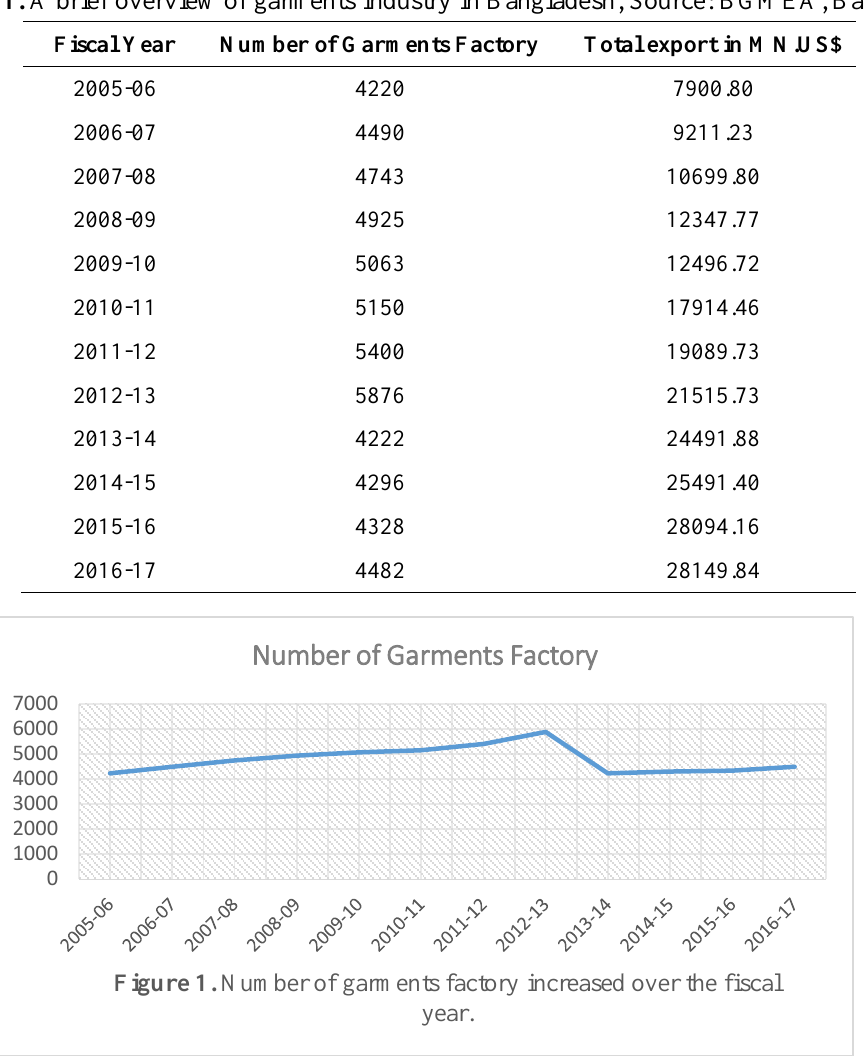
Table 1. A brief overview of garments industry in Bangladesh, Source: BGMEA, Bangladesh. Fiscal Year Number of Garments Factory Total export in MN.US$